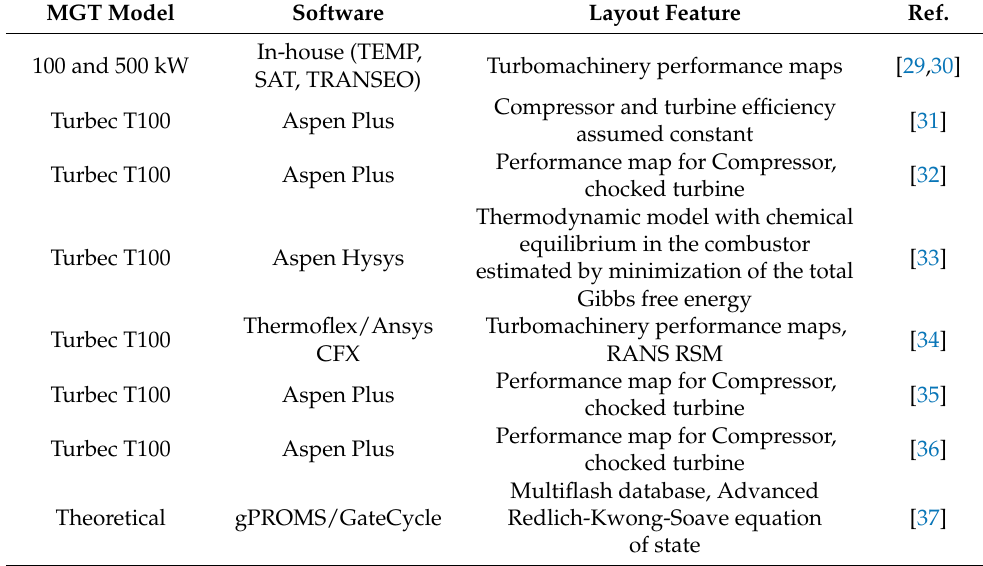
Table 2. Summary of humidified gas turbine